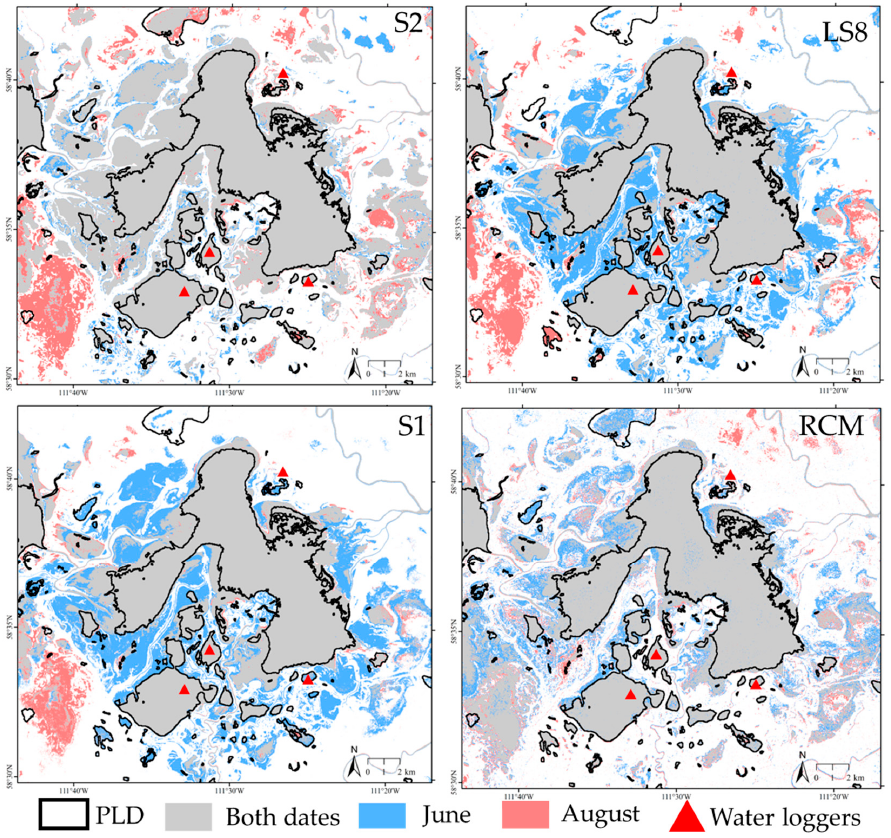
Figure 8. Mamawi Lake water surface area difference between June (blue) and August (red) for Sentinel-1, Sentinel-2, Landsat-8 and RCM-30 m. The SWOT PLD contour is shown in black lines.